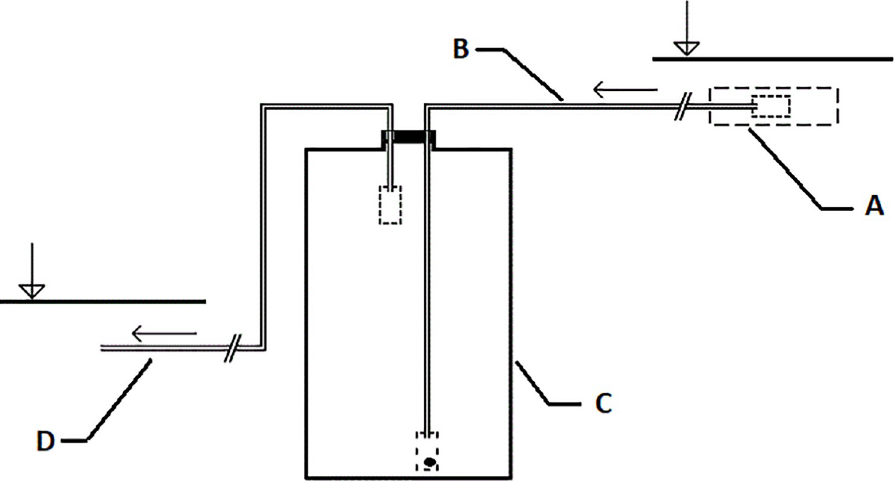
Fig 1. Scheme of detrital sampler: suction basket (1), discharge pipe (2), settling vessel (3) discharge pipe (4). The arrows indicate the difference of the water surface